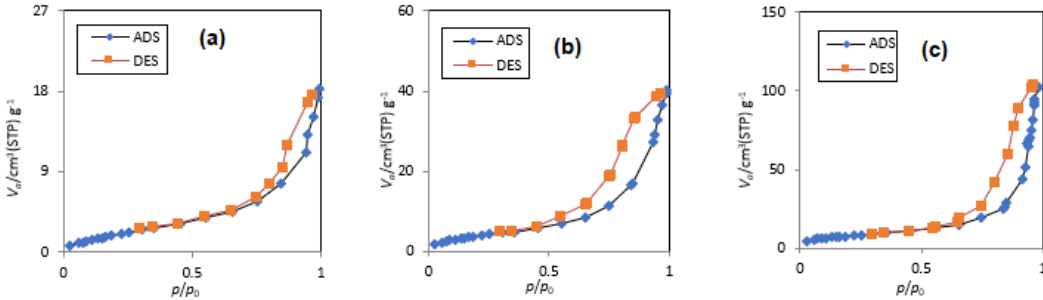
Fig. 5. N adsorption-desorption isotherms for a) Alg-Hap, b) Alg-Fe 2